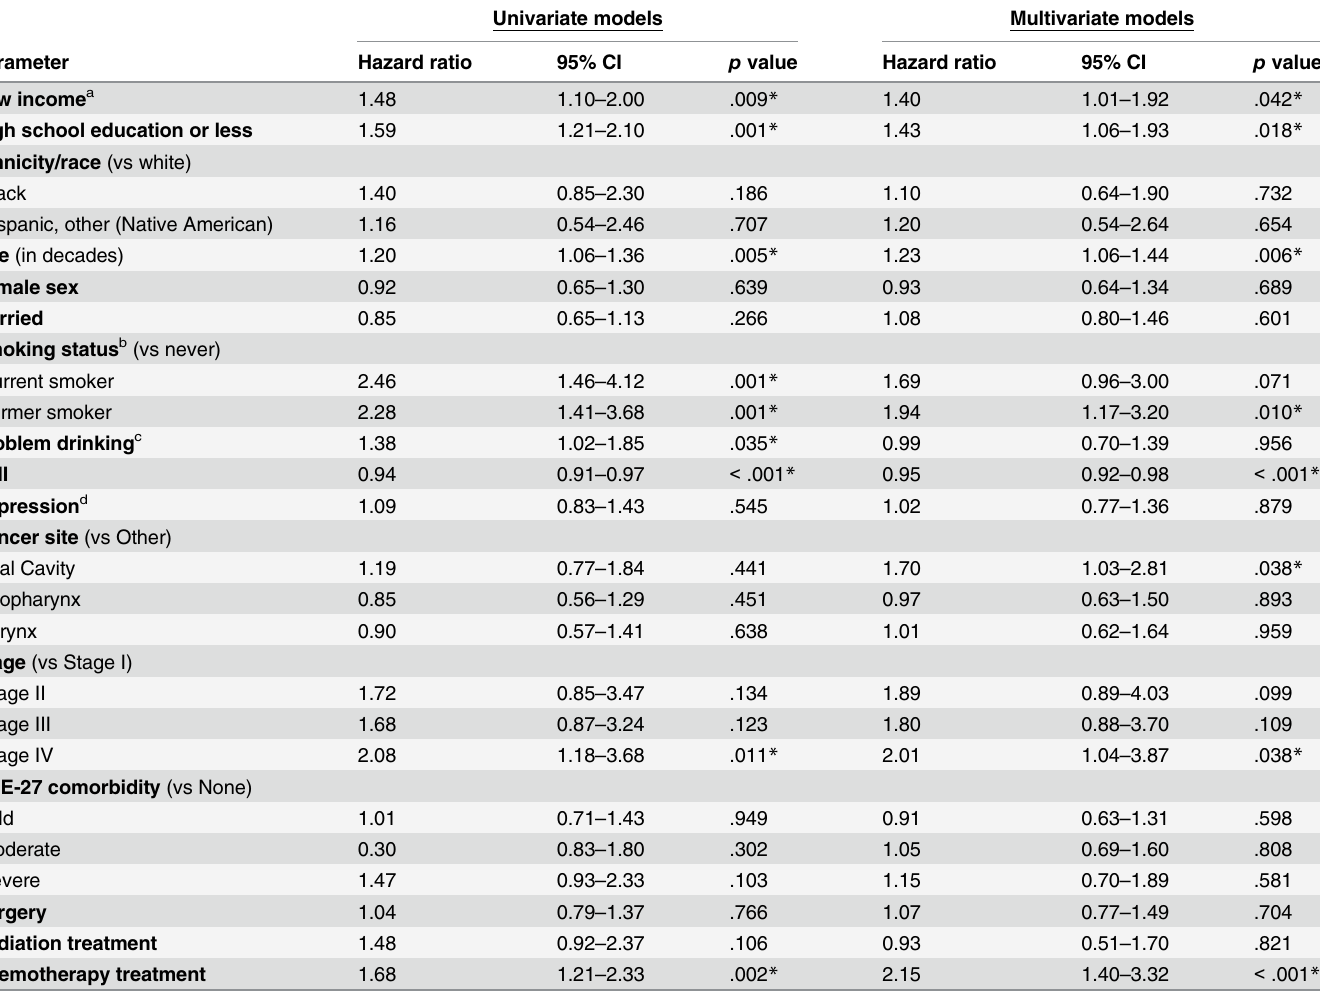
Table 5. Univariate and multivariate Cox proportional hazards model for 5-year disease-free survival (N = 634 [207 events, 427